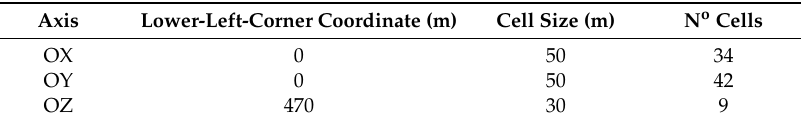
Table 2. Borehole grid (50 m × 50 m × 30 m) settings.